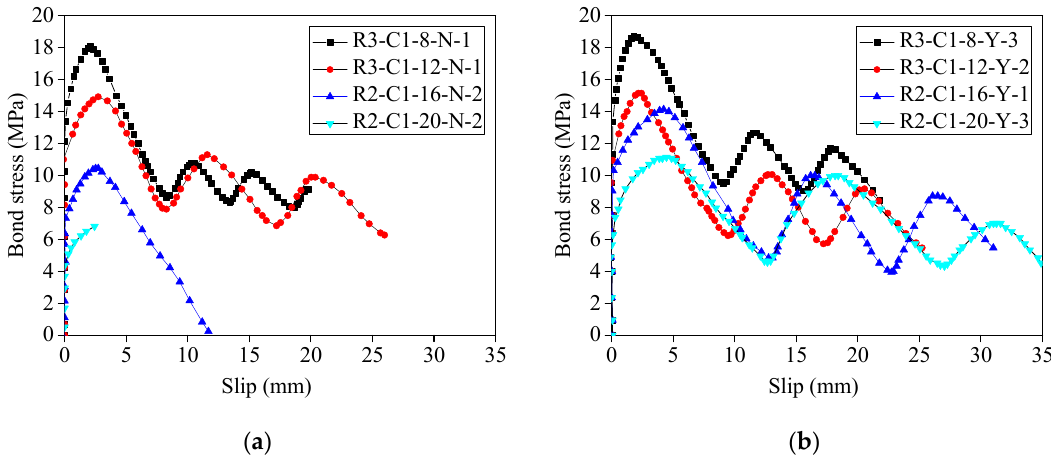
Figure 7. Representative τ - s curves for R3 bars for the ( a ) without and ( b ) with stirrups.